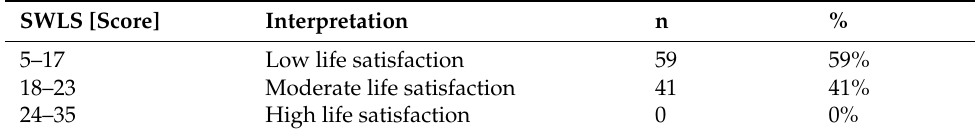
Table 4. The analysis of the SWLS results.